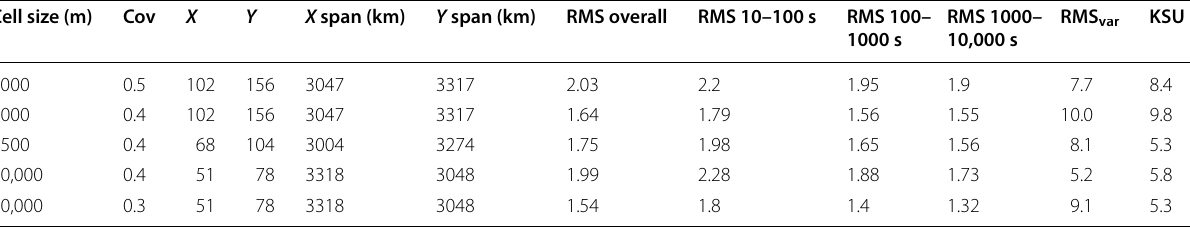
Details of the five inversions used to determine the best lateral cell size for AusLAMP inversion (5000, 7500 and 10,000 m) These were run with all the same covariance (0.4) and then with a larger covariance for the 5 km to reduce speckling (0.5) and smaller for the 10 km to get a more detailed model (0.3). The starting RMS is constant,